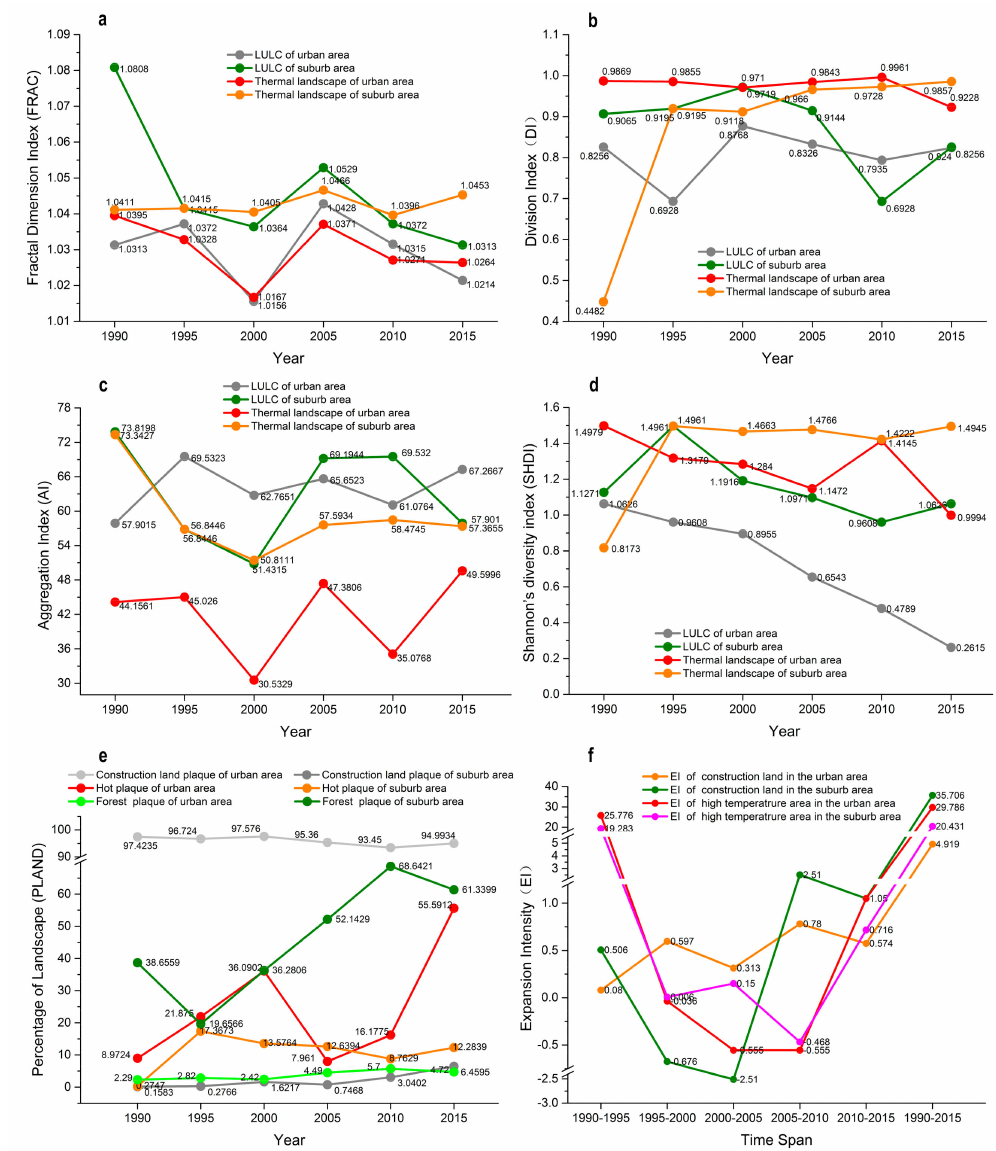
Figure 6. Changes in the landscape metrics for the LULC and thermal landscape in urban and suburb areas: ( a ) fractal dimension index (FRAC); ( b ) division index (DI); ( c ) aggregation index (AI); ( d ) Shannon’s diversity index (SHDI); ( e ) percentage of landscape (PLAND); and ( f ) expansion intensity